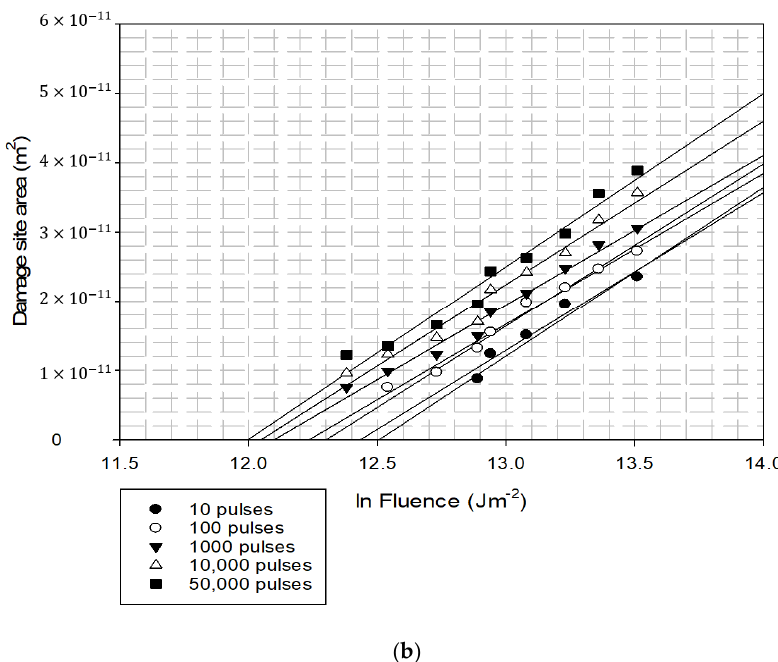
Figure 7. Graphs of laser-modified site area against ln fluence to determine the threshold fluence for various pulse numbers for ( a ) diamond and ( b ) sapphire for surface modification.